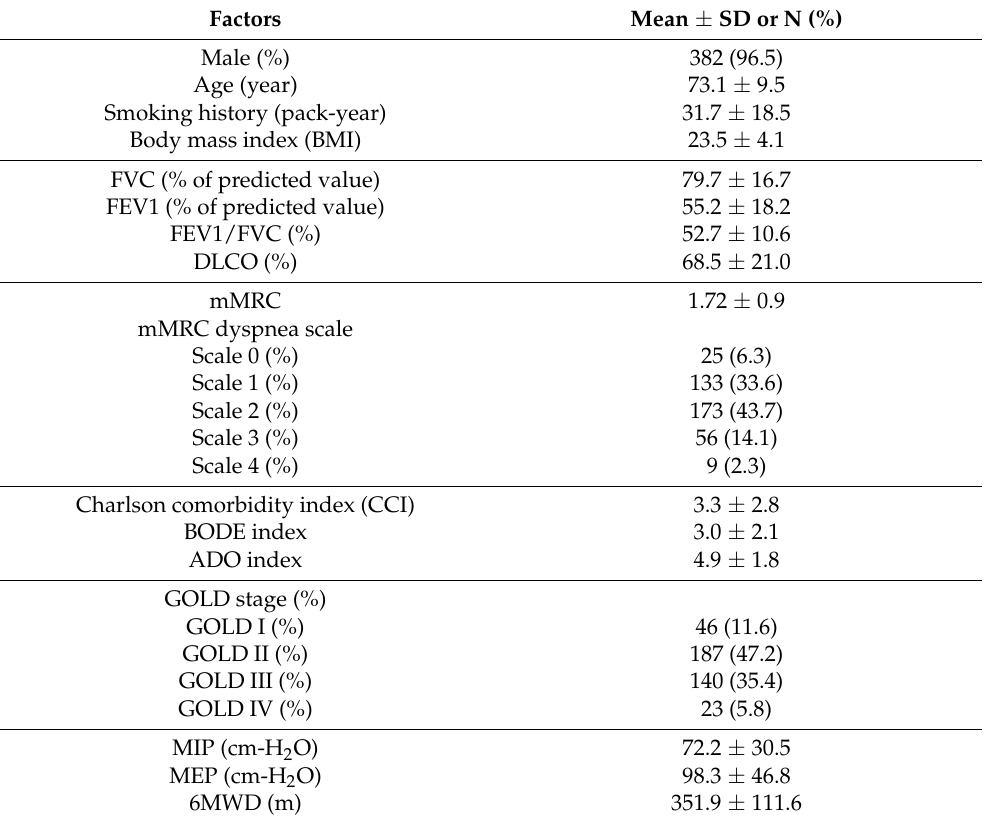
Table 1. Baseline Characteristics of Enrolled 396 COPD Patients.